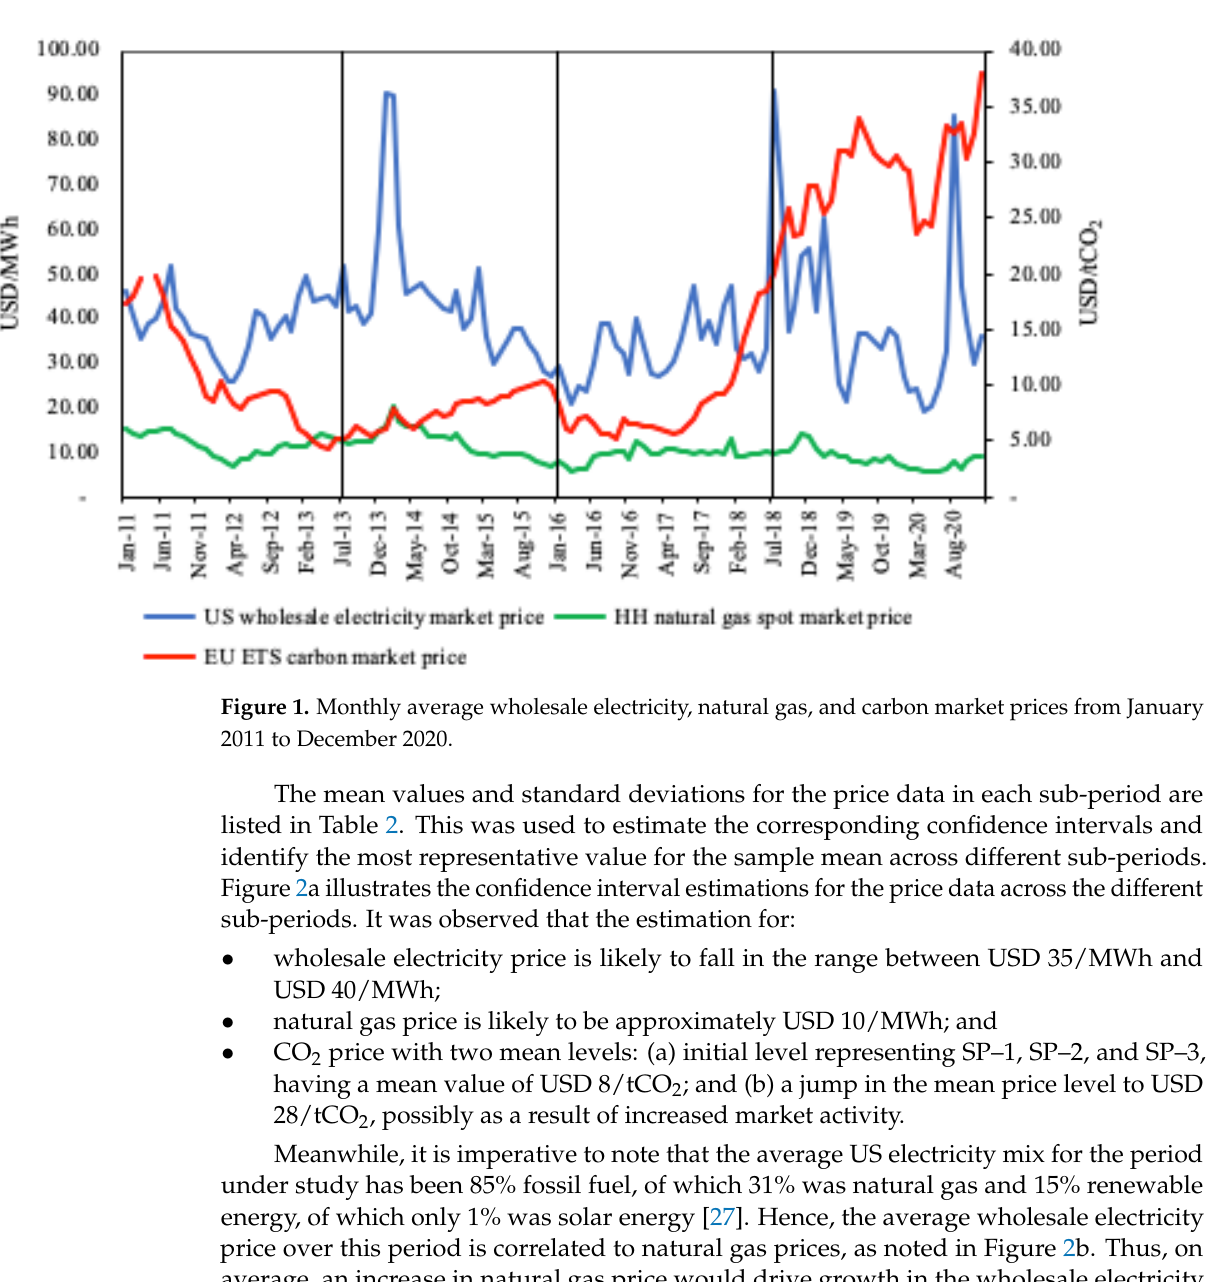
Table 2. Mean values for wholesale electricity, natural gas, and CO 2 prices for all the sub-periods.